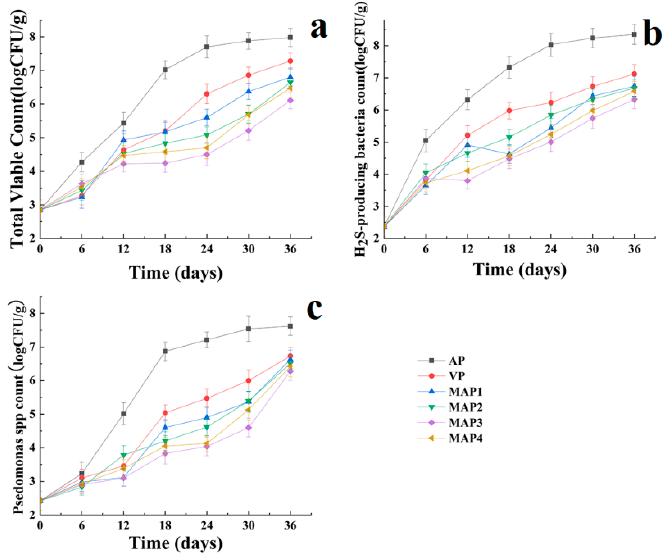
Figure 1. Changes in total viable count ( a ), Pseudomonas spp. ( b ), and H 2 S-producing bacteria ( c ) of